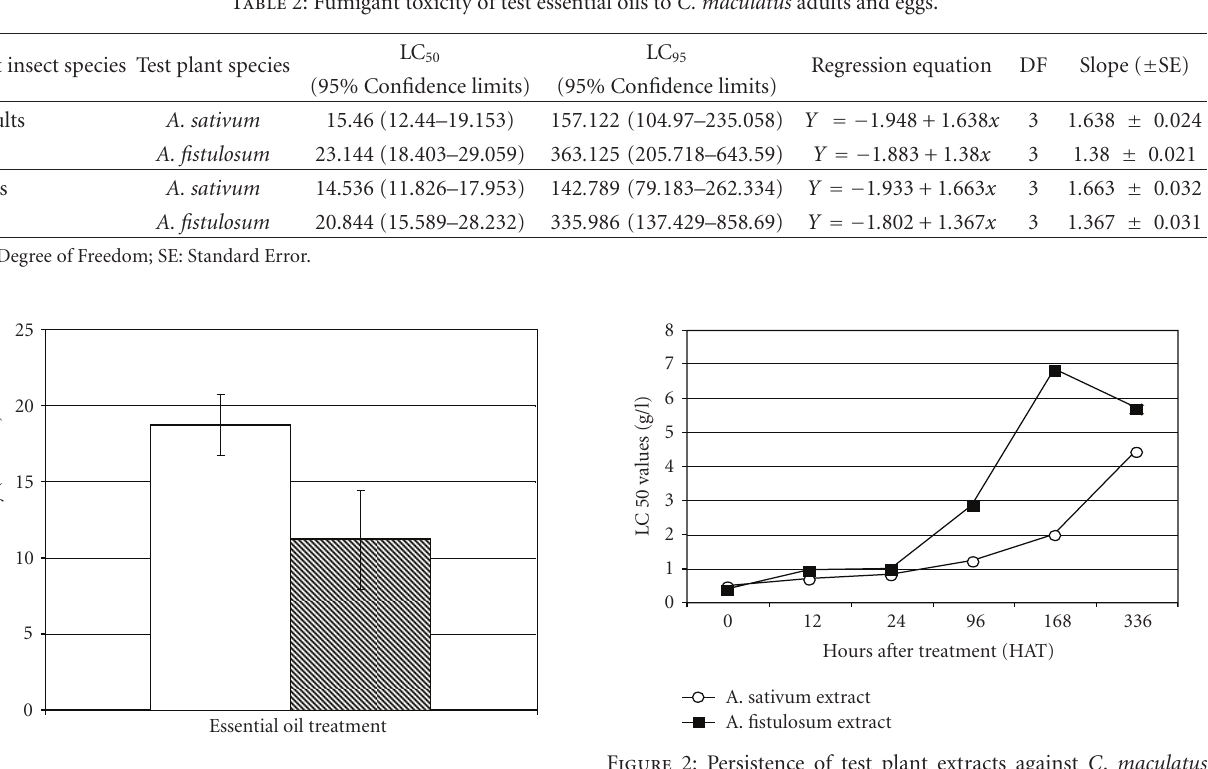
Figure 2: Persistence of test plant extracts against C . maculatus adult.